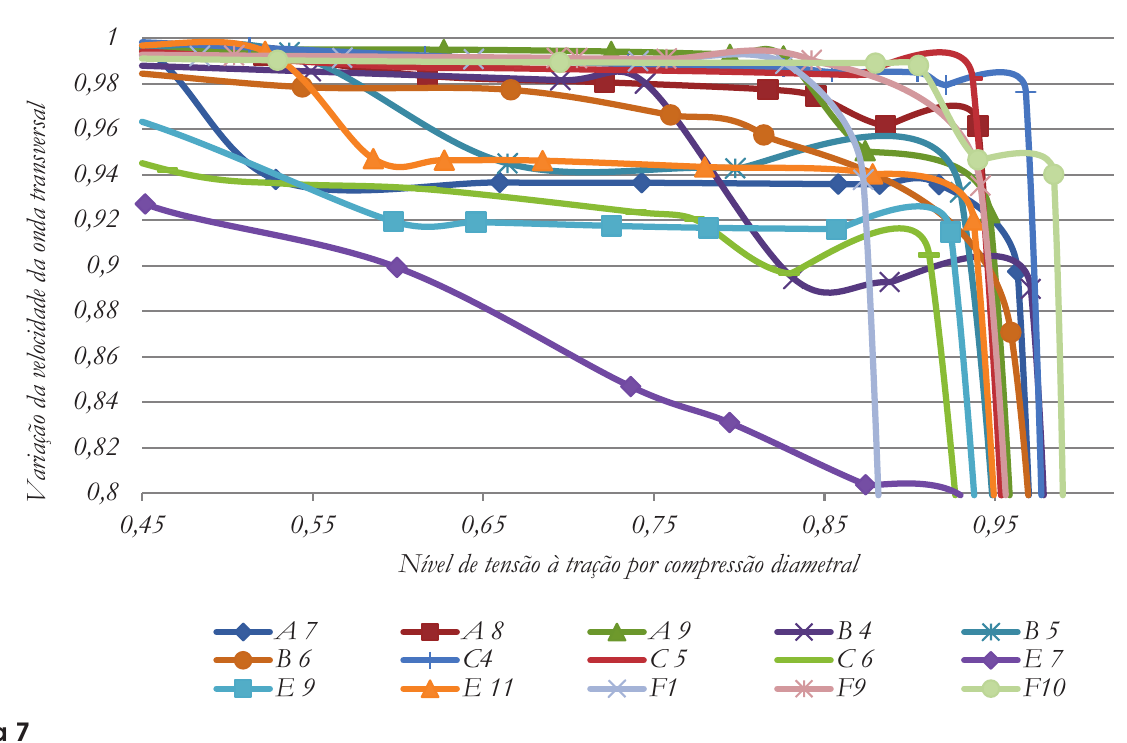
Figura 7 Resumo do comportamento da onda transversal em amostras de concreto submetidas à tração por compressão